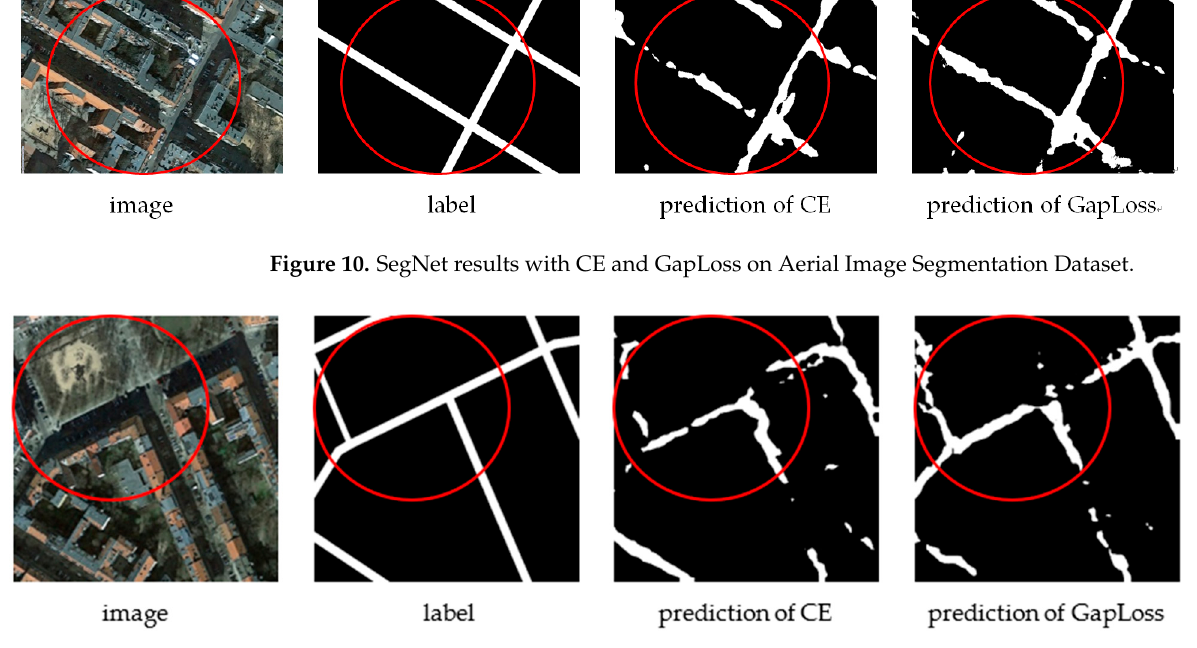
Figure 11. PSPNet results with CE and GapLoss on Aerial Image Segmentation Dataset